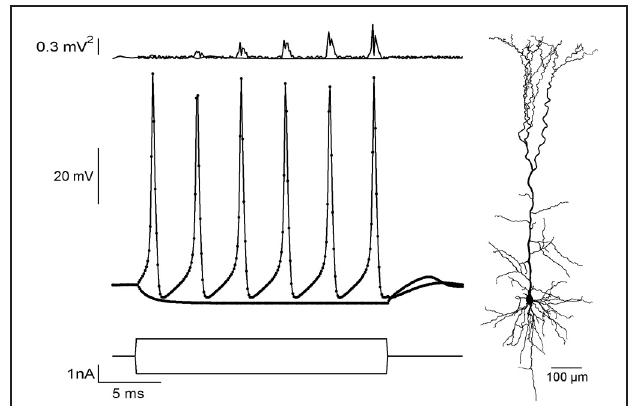
FIGURE 2 | Comparing current-clamp simulations in NEURON and CUDA. Bottom : Current-clamp protocols for passive and active responses. Middle : Voltage responses of a pyramidal neuron simulation (morphology at the right) using NEURON (dots) and CUDA (solid line). Top : Squared error values between NEURON and CUDA platforms for both passive and train